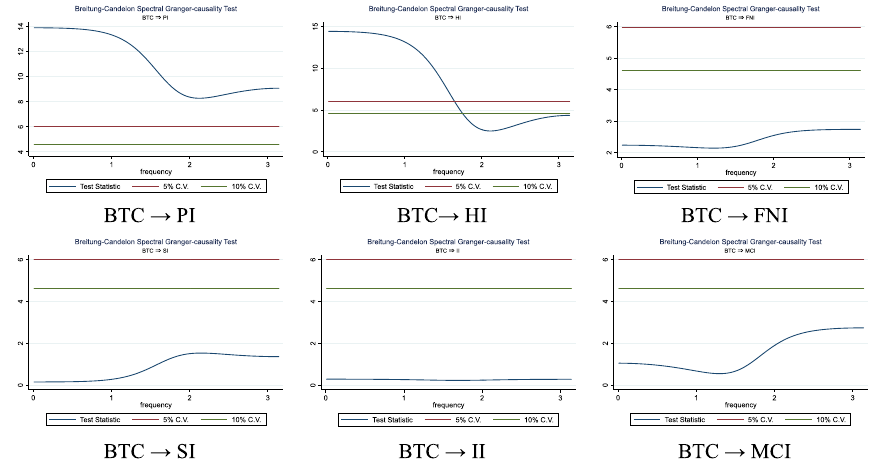
Fig. 8 Plots of frequency domain Granger causality test from Bitcoin to RavenPack coronavirus-related indices. Source Authors’ own work. Notes: The incidence of the connection between daily changes of Bitcoin price and each RavenPack coronavirus-related indices is investigated at frequencies 2–3, 1–2, and 0–1. These frequencies show a short, medium, and long-term relationship. 0–1 is established as permanent causality, while 2–3 is recognized as temporary causality. The (red) upper line and the (brown) lower line represent statistically significant levels of 5% and 10%, respectively. The (blue) curves are used for statistical tests of various interval frequencies (0, π). Variables’ description is provided in Table